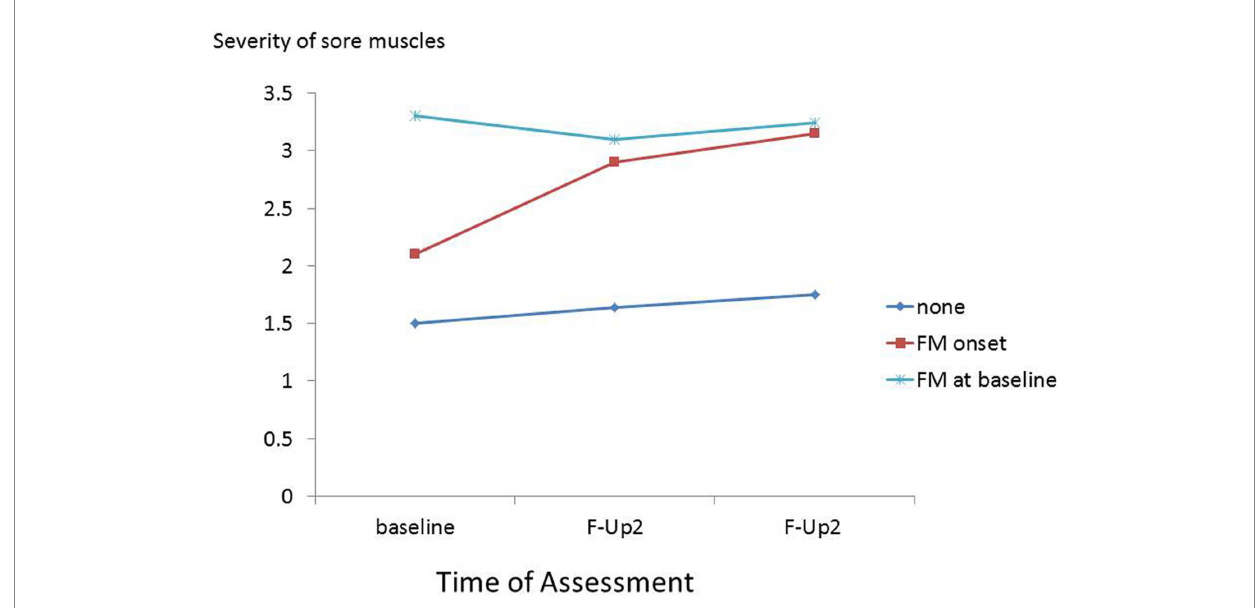
FIGURE 3 Severity of muscle pain at baseline, first and second follow-ups in participants with baseline fibromyalgia and those without baseline fibromyalgia who during follow-up, reported onset of fibromyalgia, and did not report onset of